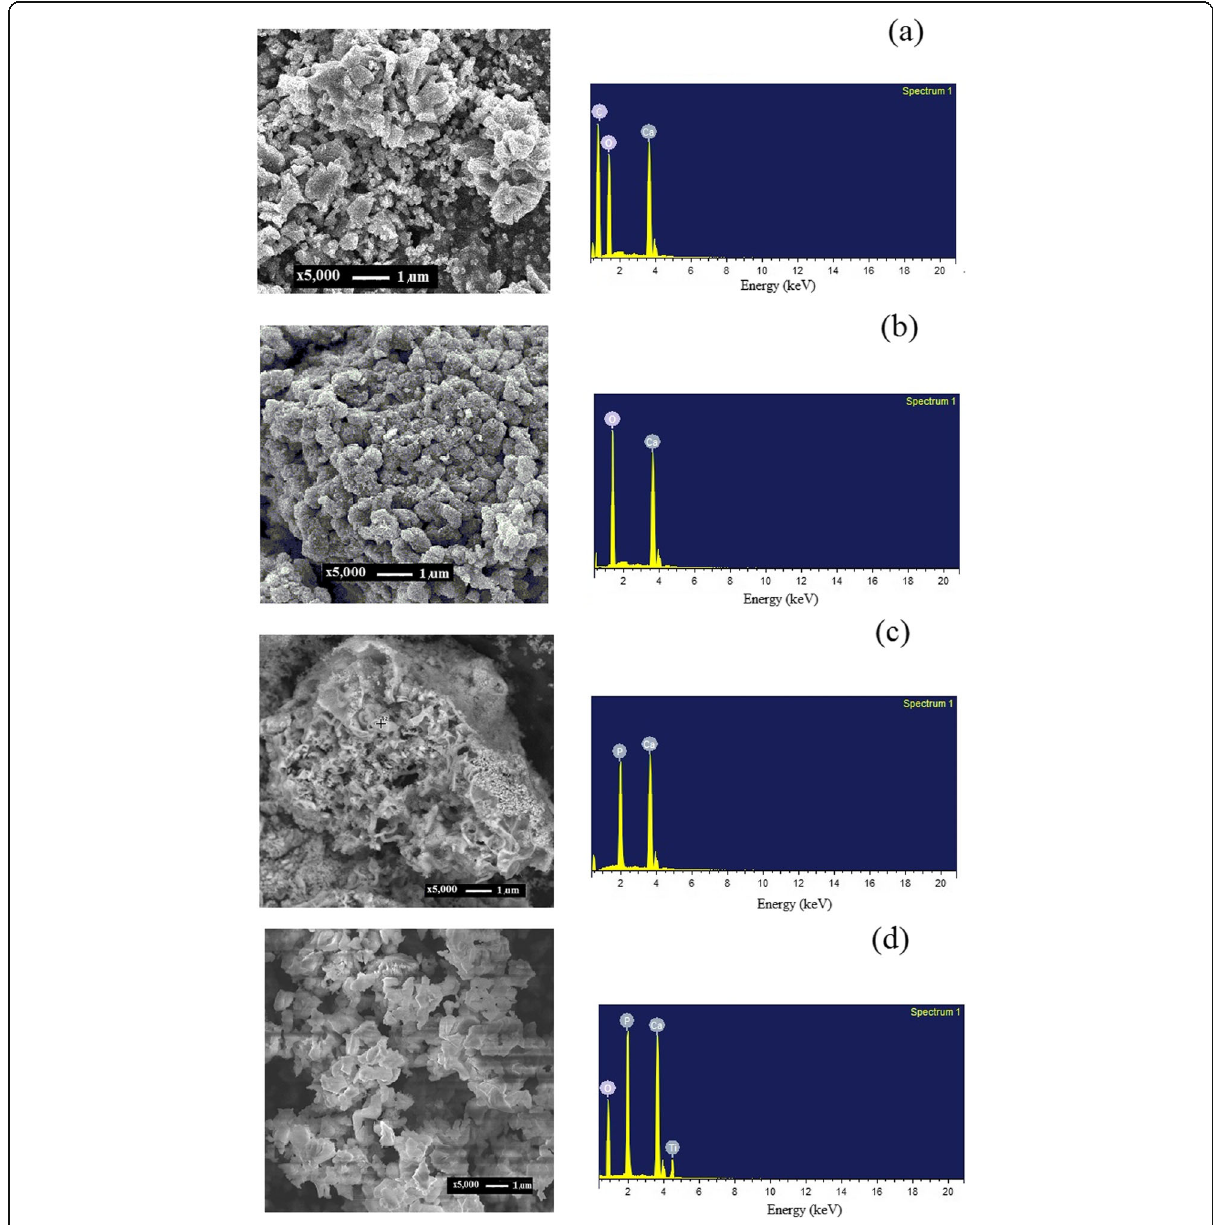
Fig. 3 SEM profile and EDX spectra of ( a ) Cockle shell, ( b ) CaO, ( c ) HAp, and ( d ) HAp- n TiO